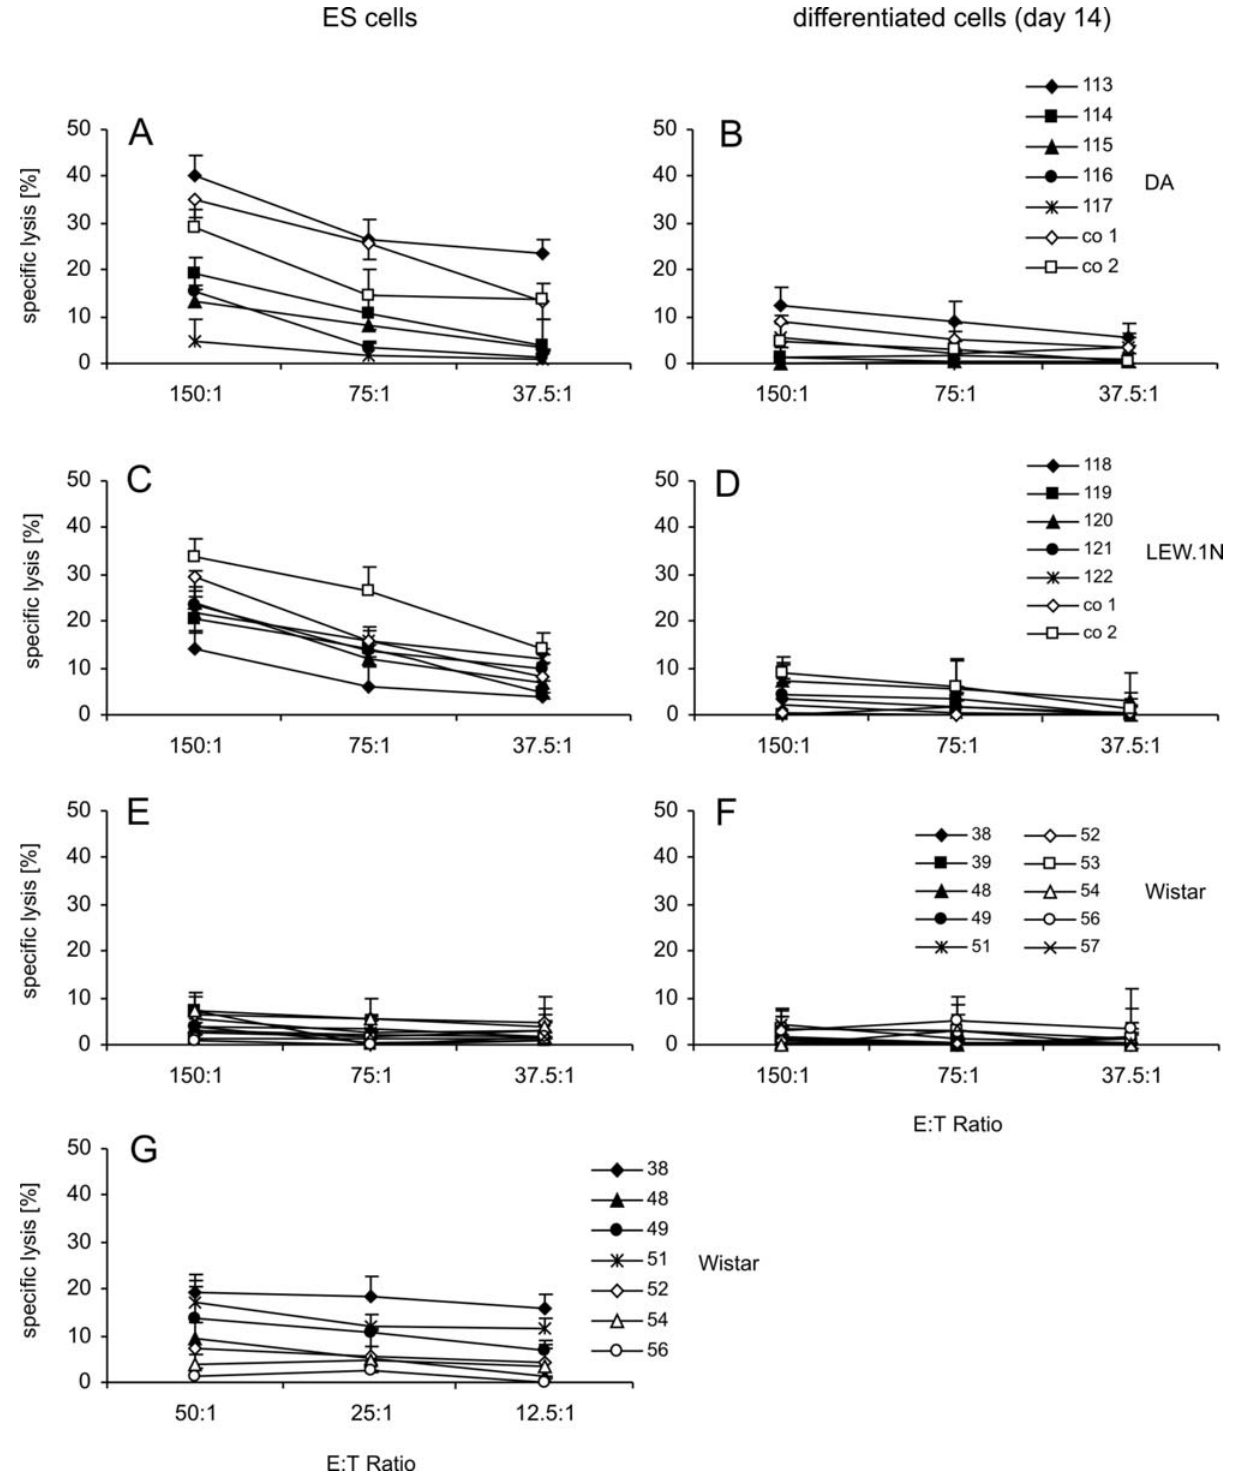
Figure 7. Lysis of ES and invitro differentiated cells by splenocytes derived from rats 6 weeks after intracerebral grafting of invitro differentiated cells. Mean of specific lysis and SD of triplicates of ES cells (A, C, E, G) or in vitro differentiated cells (B, D, F) at three effector:target (E:T) ratios. Effector cells were lymphocytes obtained by density gradient centrifugation on Biocoll from spleens of grafted (no. 113–117) or naı¨ve (co1 and co2) DA rats (A, B), grafted (no. 118–122) or naı¨ve (co1 and co2) LEW.1N rats (C, D), and grafted Wistar rats (no. 38, 39, 48, 49, 51, 52, 53, 54, 56, 57). The individual rats are indicated by symbols. (G) Mean of specific lysis and SD of triplicates of ES cells by lymphokine-activated killer (LAK) cells derived from splenocytes of Wistar rats (no. 38, 48, 49, 51, 52, 54, 56) after culture for 4 days in the presence of 100 U/ml IL-2.